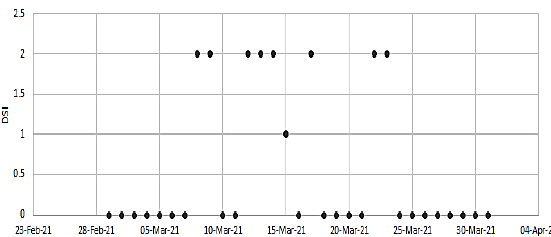
Figure 10. Dust Storm Index from 03/01 to 03/31, 2021 in Taguig City.